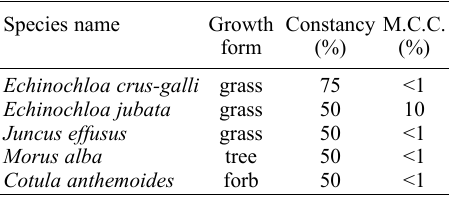
Table 10 Diagnostic species of the Echinochloa crus-galli- Paspalum distichum grassland (M.C.C. - mean canopy